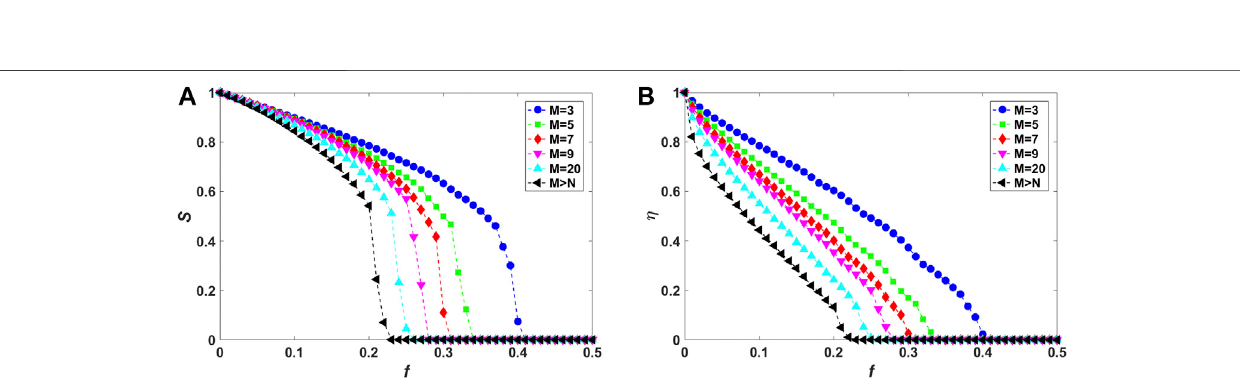
FIGURE 5 | (Color online) Vulnerability analysis of fully interdependent local-world networks (corresponding to interdependence strength q (cid:2) 1 . 0) after cascading failurescausedbyintentional removal ofhigh-degree nodesfrom onenetworkinthe caseofdisassortativeinterdependence. (A) Relative size S ofthelargestconnected componentasafunctionofthefraction f ofremovednodes; (B) residualcommunicationef fi ciency η asafunctionofthefraction f ofremovednodes.Resultsareobtained by averaging over 50 independent realizations on interdependent systems consisting two local-world networks, which are separately constructed with N (cid:2) 2000, m (cid:2) 3, and 〈 k 〉 (cid:2) 2 m (cid:2) 6 for different M ( M (cid:2) 3 , 5 , 7 , 9 , 20 and M > N